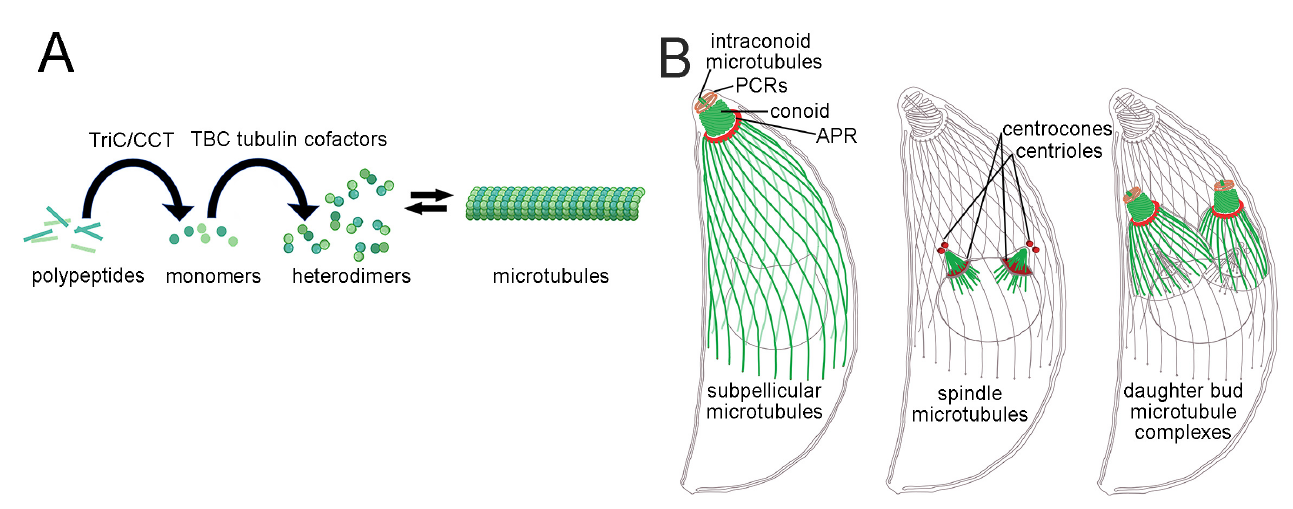
Figure 1. Tubulin, microtubules, and Toxoplasma microtubule-based structures. ( A ) Tubulin biogenesis requires TRiC-mediated polypeptide folding to form GTP-bound α - and β -tubulin monomers. TBC tubulin cofactors subsequently facilitate stable heterodimer formation. Genetic alterations or pharmacological inhibition of the TRiC/CCT chaperone reduces levels of functional tubulin subunits and influences microtubule dynamics. Tubulin-targeting agents shift the equilibrium between tubulin heterodimers and assembled microtubules to stabilize or destabilize microtubules. ( B ) To best illustrate the location and organization of the subpellicular, spindle, and daughter-bud subpellicular microtubules, each is shown individually, although all occur at the same time in replication of tachyzoites. Toxoplasma tachyzoites have an elongated shape imposed by association of a corset of non-dynamic subpellicular microtubules with the cytoplasmic face of the pellicle. These microtubules radiate out from the apical polar ring (APR), and a tubulin-based conoid can extend from or retract into the APR. The conoid is surmounted by two preconoidal rings (PCRs), and two microtu- bules traverse the conoid lumen. Intracellular parasites replicate using a closed mitosis coordinated by an intranuclear spindle to segregate chromosomes. Cytoplasmic spindle poles are associated with centrioles, and each hemispindle enters the nucleus through a specialized region of the nuclear envelope termed the centrocone. Toxoplasma replicates by endodyogeny, a form of internal budding. A daughter bud encloses each spindle pole. Buds consist of an inner membrane complex (IMC) associated with subpellicular microtubules and a conoid complex. Daughters emerge from the mother parasite by adhesion of the maternal plasma membrane to the daughter IMC that forms the mature pellicle.